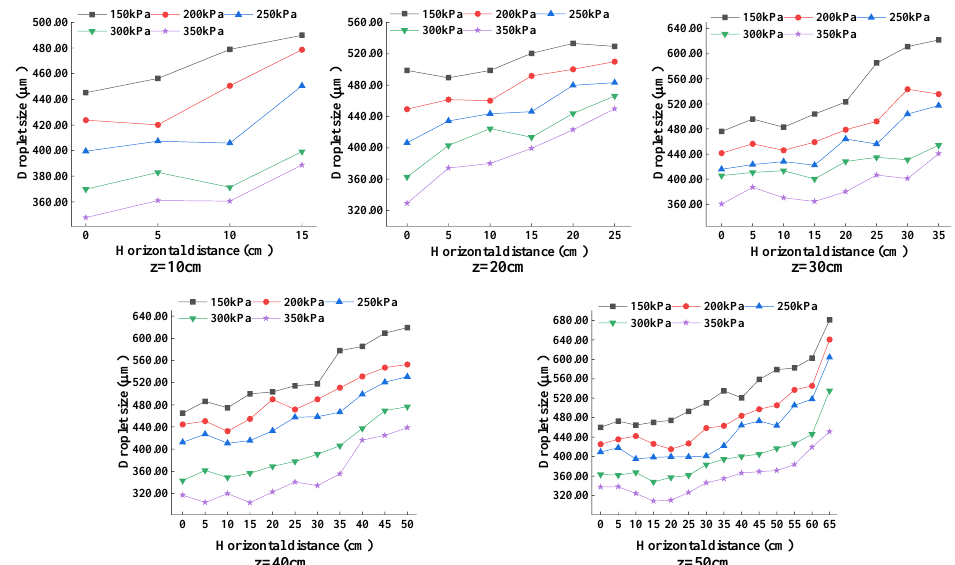
Figure 5. Horizontal direction droplet size D X distribution in different pressure. The distribution of droplet size D X on the X axis of the adjuvants is shown in Figure 6. It can be seen from the figure that, compared with water, Maisi, Surun, AdseeAB-600 and Maidao adjuvants have an increasing trend on droplet size. At the same position of the horizontal section, the droplet size of the Maisi is the largest in the horizontal direction, and the droplet size of Adsee AB-600 and the Maidao are close, and the smallest is the Surun.